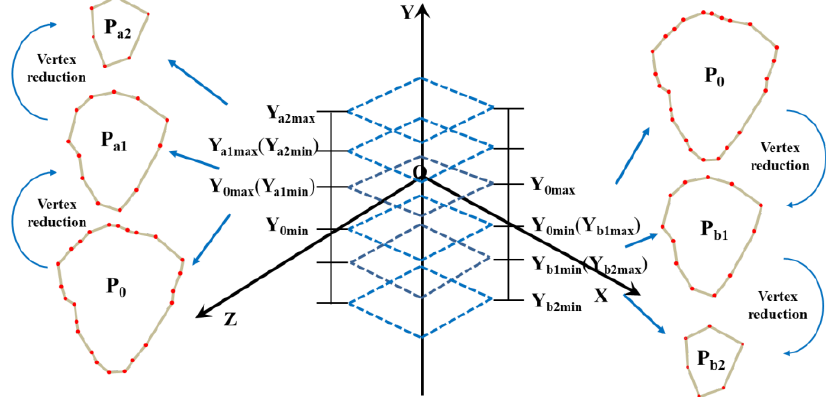
where H max is the maximum aggregate thickness; L x is the maximum width of P parallel to the x -axis; α is a number that is more than zero but less than one. Aggregate surfaces will get flatter as the value of α decreases. (4) The bottom and top restrictions for the y coordinates of each polygon were determined according to the height of aggregate, and the y coordinates of each vertex were randomly generated within the lower and upper limits. Figure 2 illustrates a schematic diagram of all vertices of the generated three-dimensional aggregate.